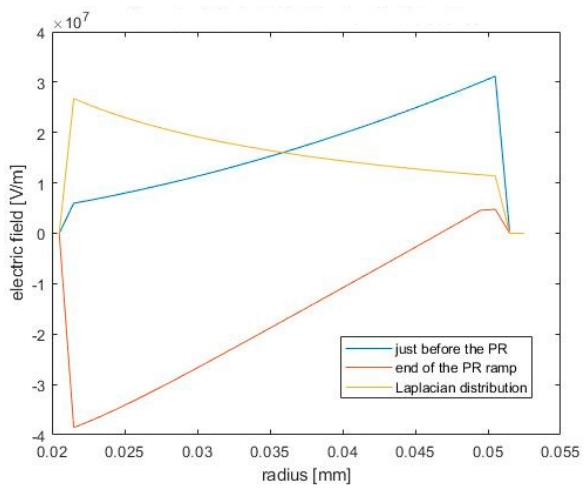
Figure 10. Radial electric field distributions—Scenario D.